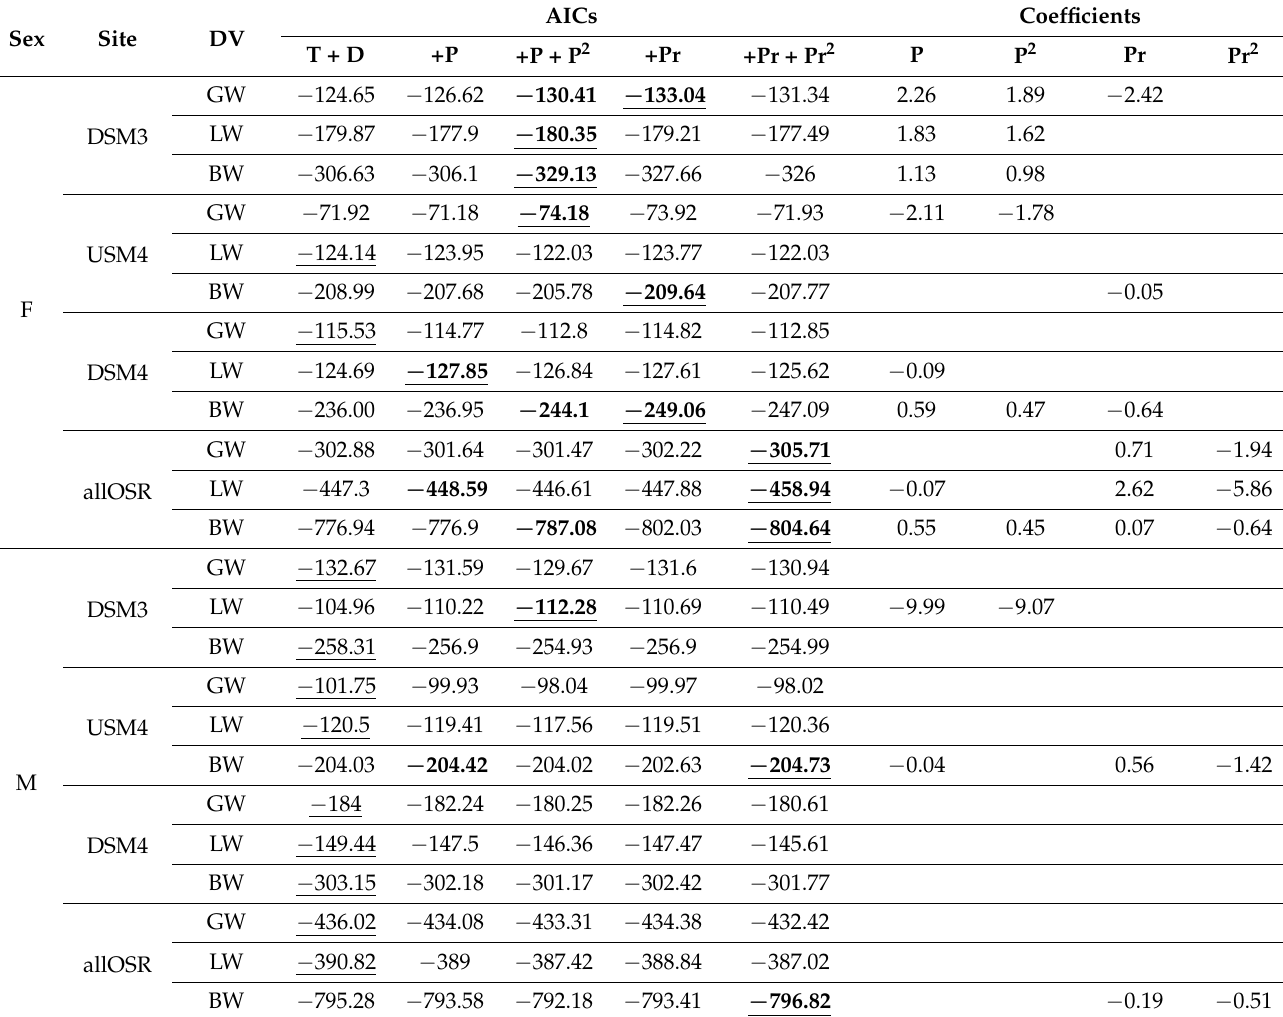
Table 2. AICs for original models (See Supplementary Table S1) supplemented with temperature (T), discharge (D), sewage phosphorus (P), and precipitation (Pr) on residual dependent variables (DV) of gonad weight (GW), liver weight (LW), and body weight (BW) by sex, site, and year; AICs in bold indicate the improvement of the T + D model per column variable; best fit models for all evaluated coefficients shown as underlined AICs; coefficients for improved models using P and Pr also